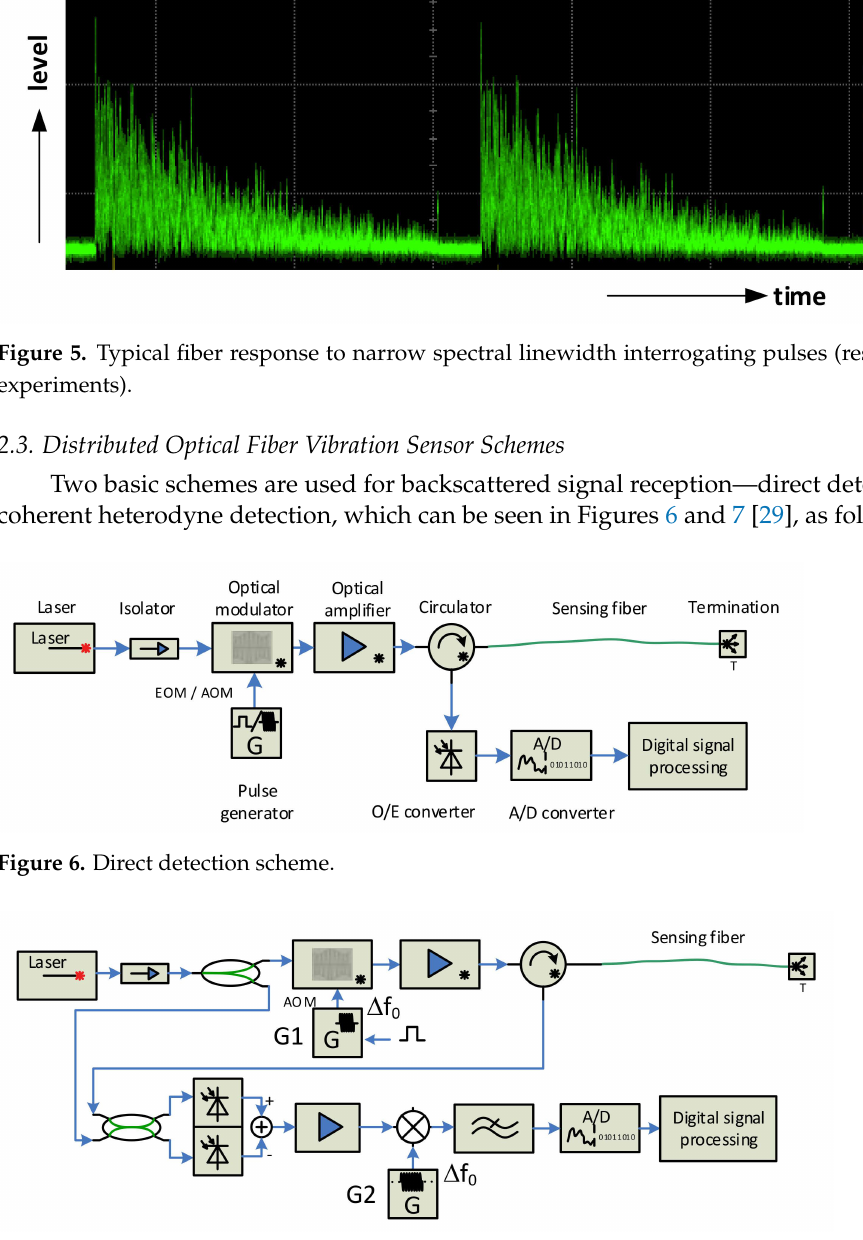
Figure 7. Coherent heterodyne detection